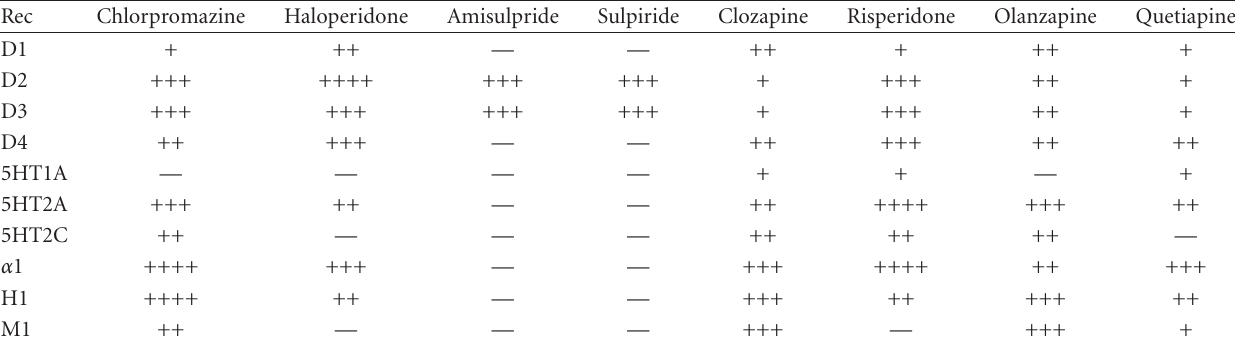
Table 1: The relative a ffi nities for selected receptors of some antipsychotic